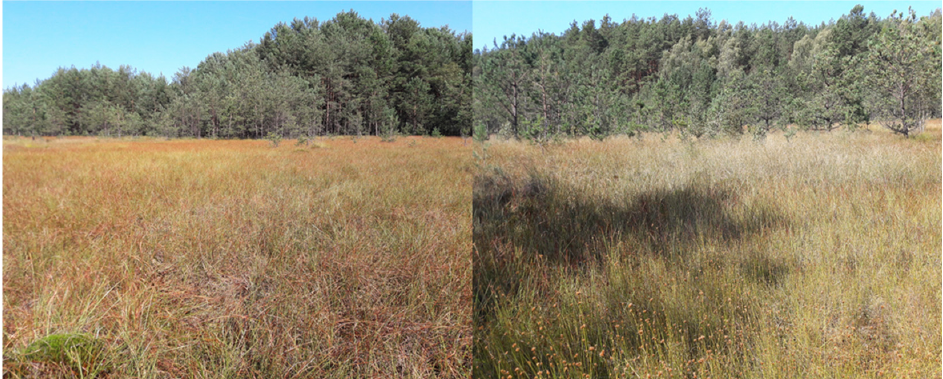
Figure 15. 7140 habitats in the JF area with discolored Eriophorum angustifolium (left picture) and flowering Rhynchospora alba (right picture).